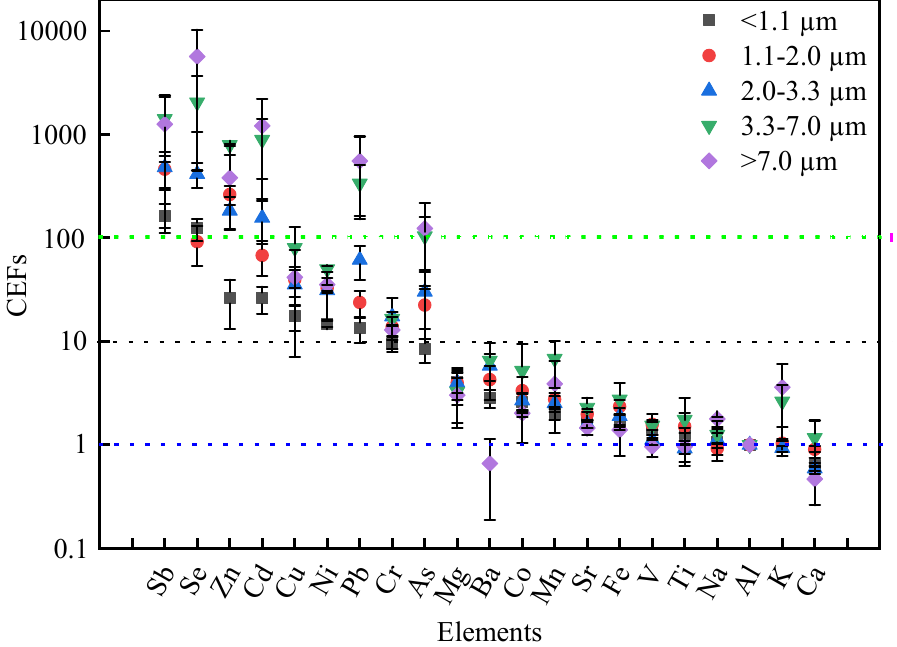
Figure 8. The crustal enrichment factors (CEFs) of each element of size-segregated particles in Beijing. The blue dashed line indicates that CEFs are less than 1. The black dashed line indicates that CEFs are less than 10. The green dashed line indicates that CEFs are less than 100.